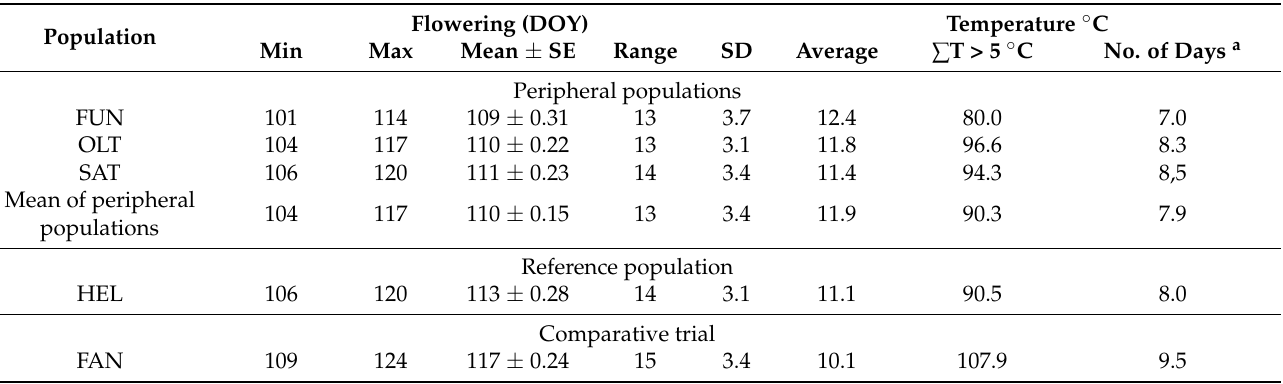
Table 6. Representative flowering phenophase dates for sessile oak observed in the studied popula- tions and the FAN comparative trial.